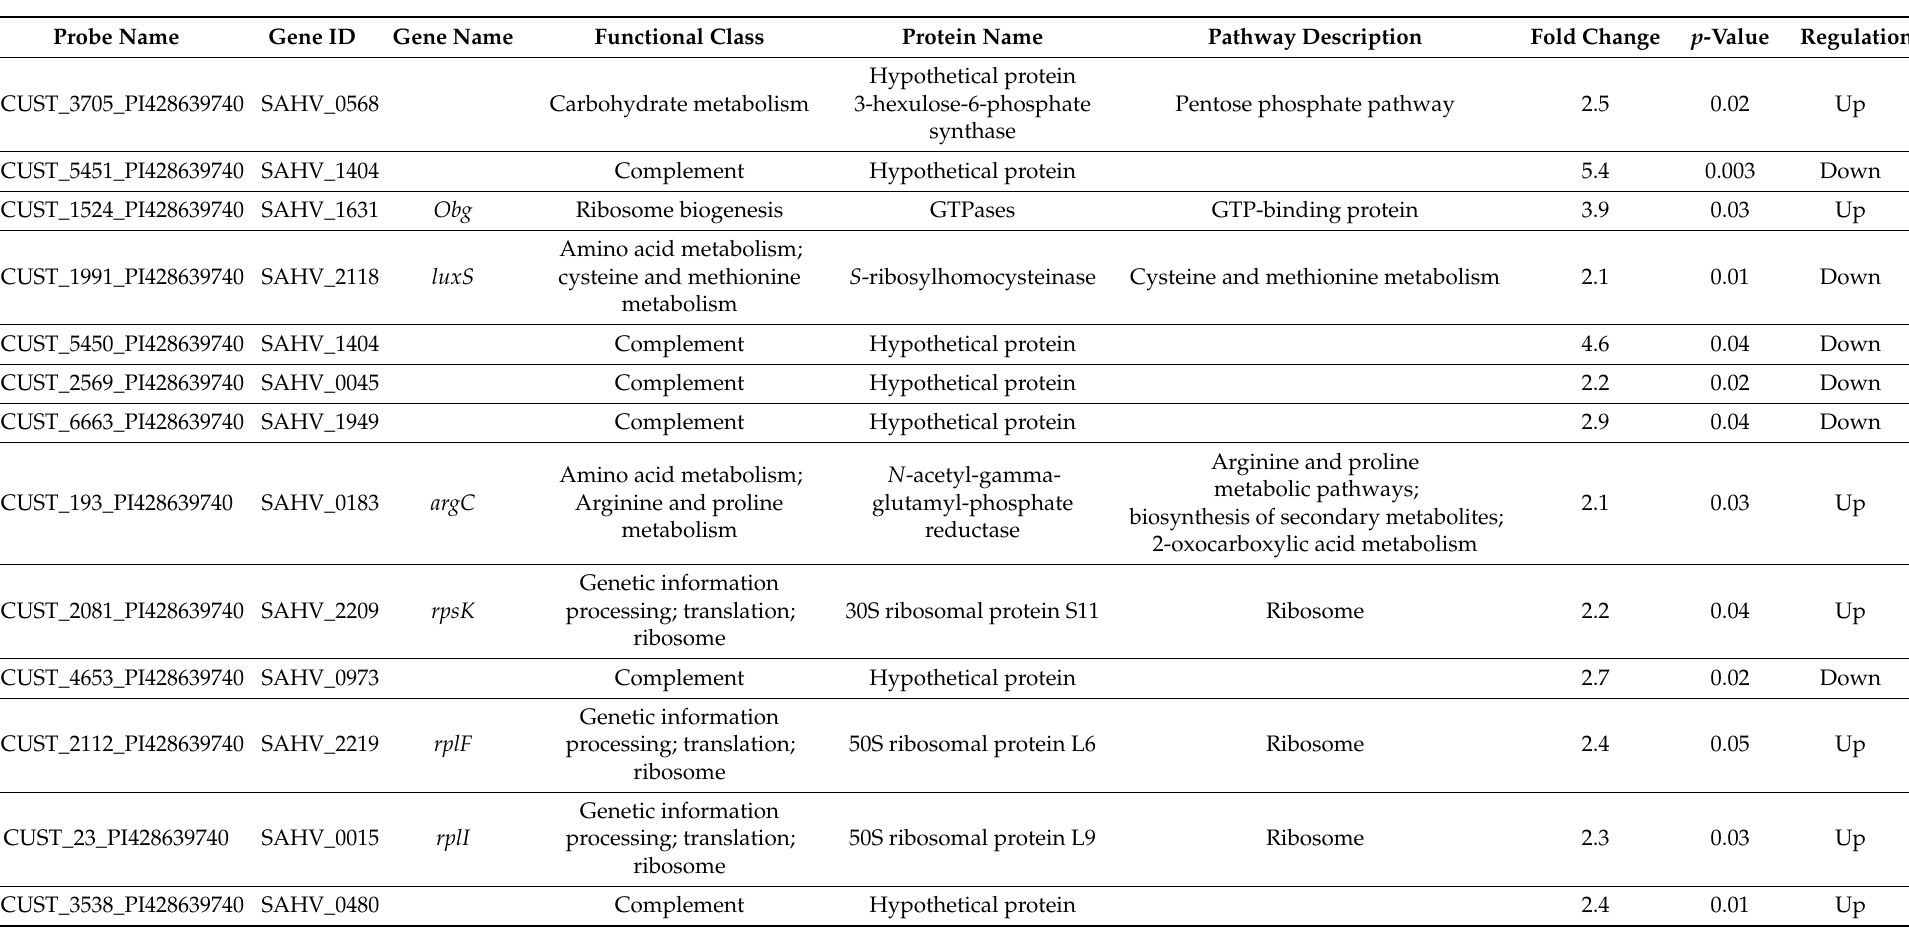
Table 1. List of genes expressed in response to eugenol treatment of methicillin-resistant Staphylococcus aureus , and their fold changes, p -values, and functional classifications; FC: fold